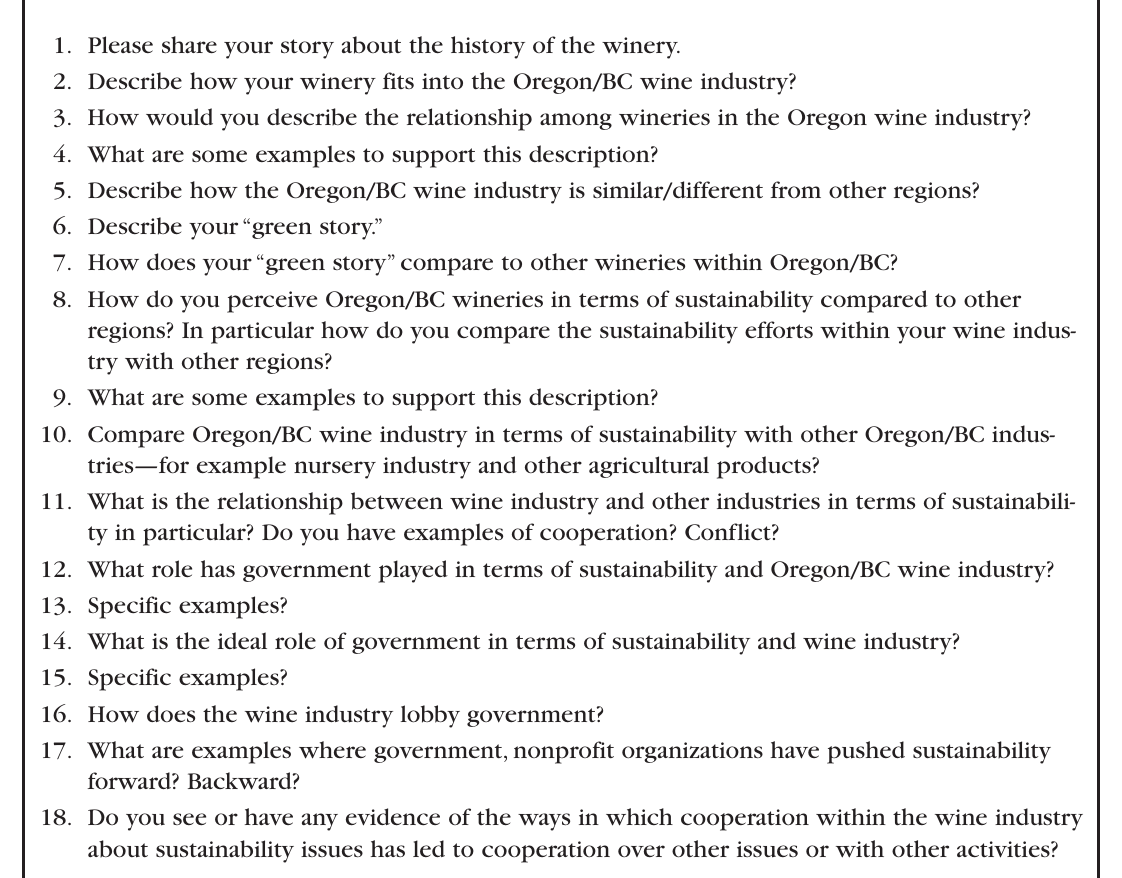
Table 1. Interview